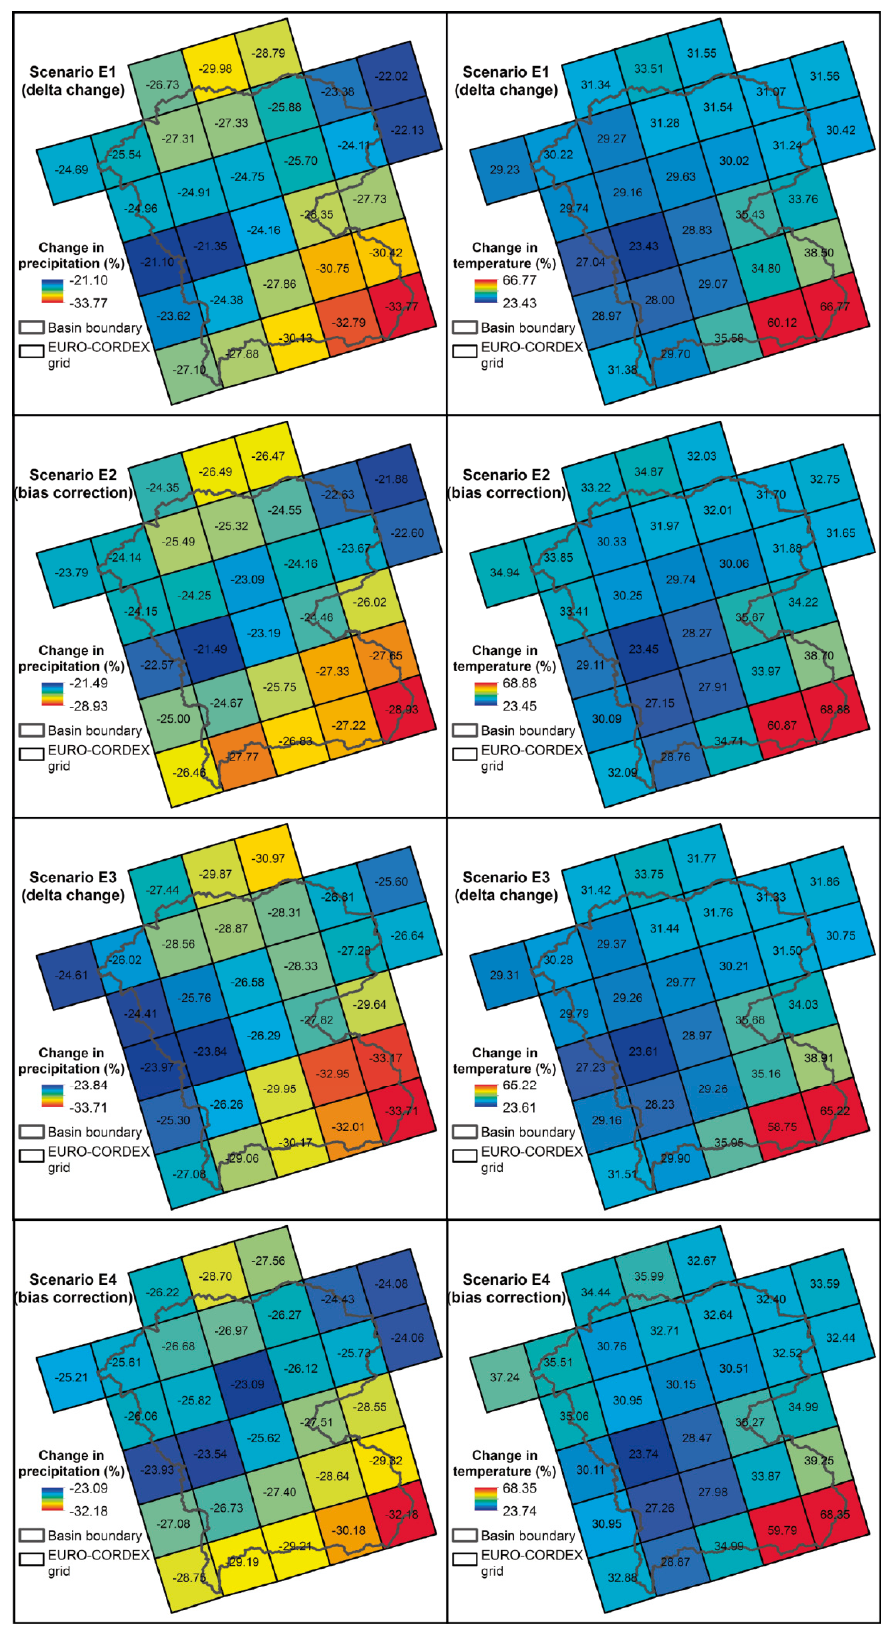
Figure 14. Spatial distribution of the mean relative change (expressed in %) in precipitation and temperature obtained by the four ensemble options (E1, E2, E3, and E4)—distributed approaches.